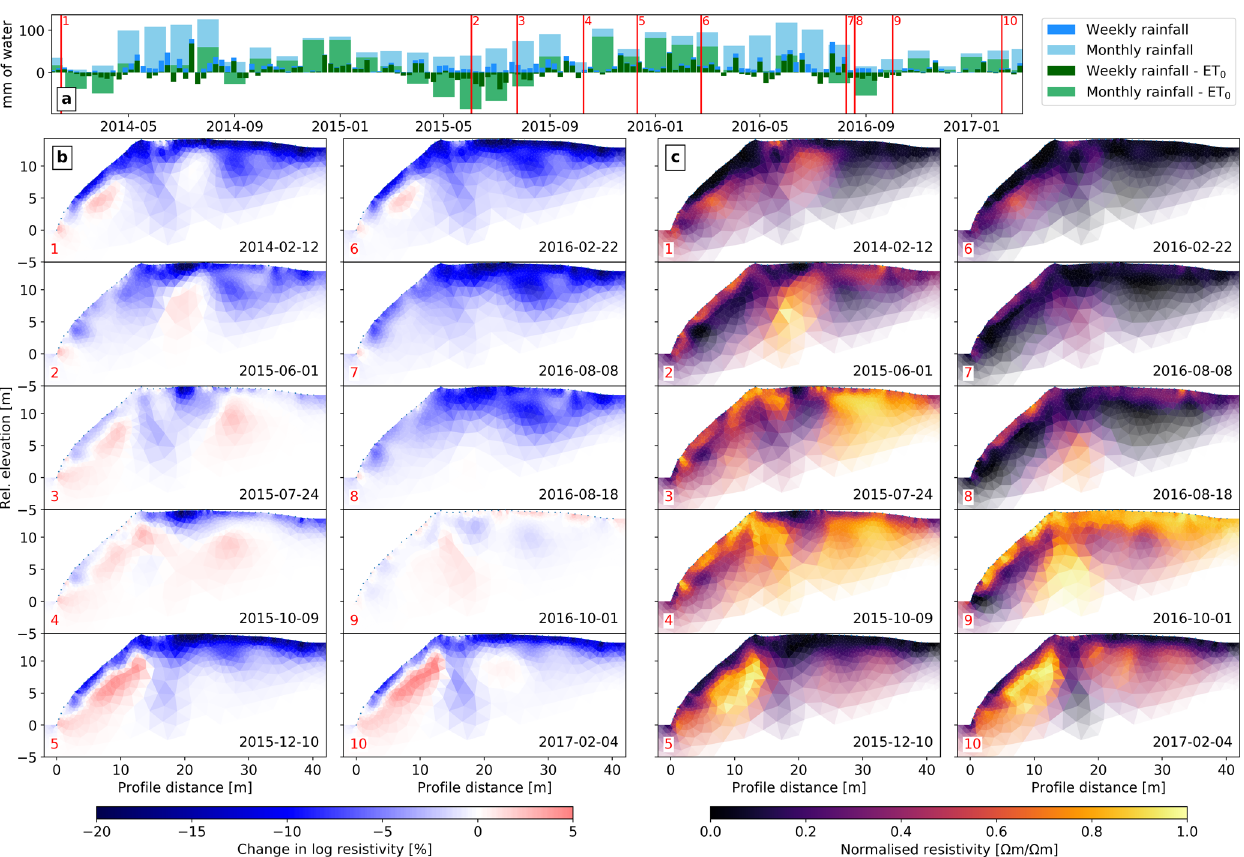
Figure 6. (a) Rainfall and effective rainfall. (b) Changes in log resistivity (see Eq. 1) for 10 of the 467 DD data sets, as highlighted in Fig. 6a. (c) Normalised resistivity (see Eq. 2) for the same data sets. See the Supplement for an animation of the resistivity variations for the whole time series of the DD and GD data